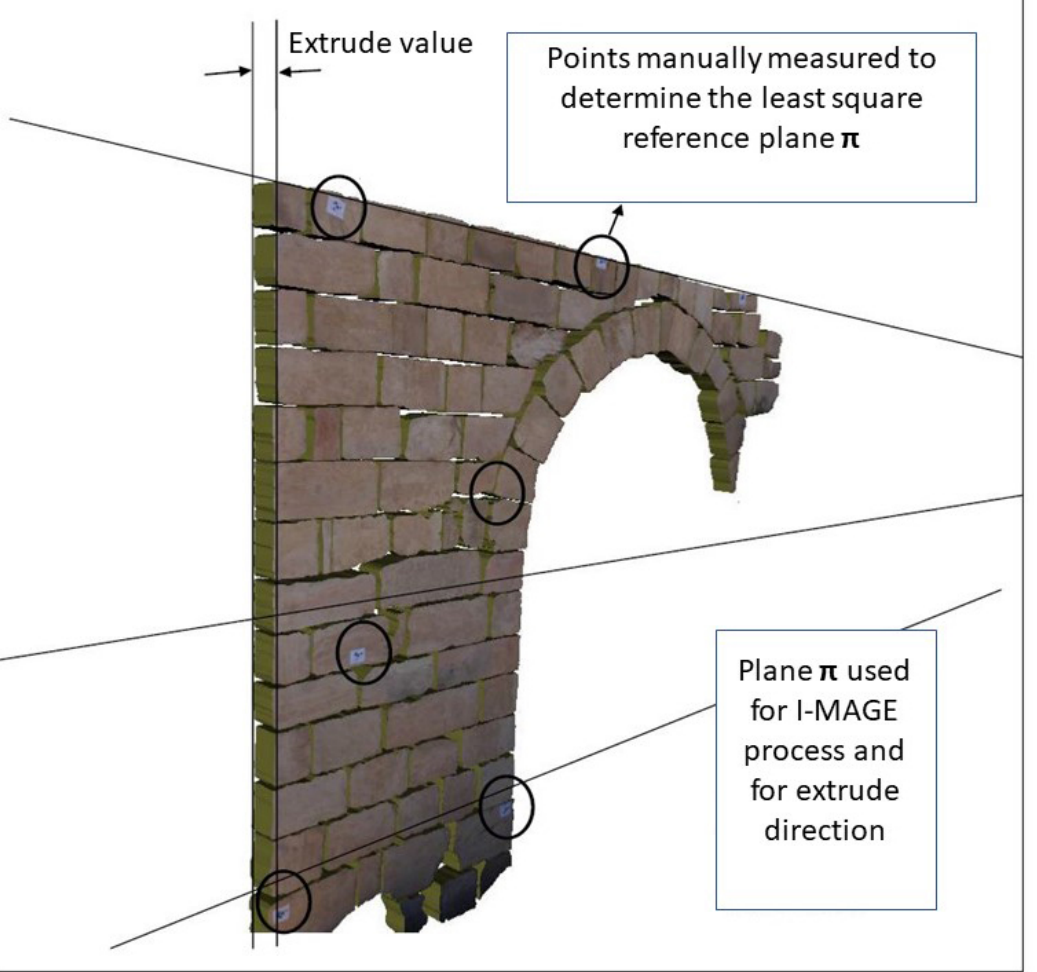
Figure 7. Ashlar blocks using a plane as an approximation of the exterior face of the wall